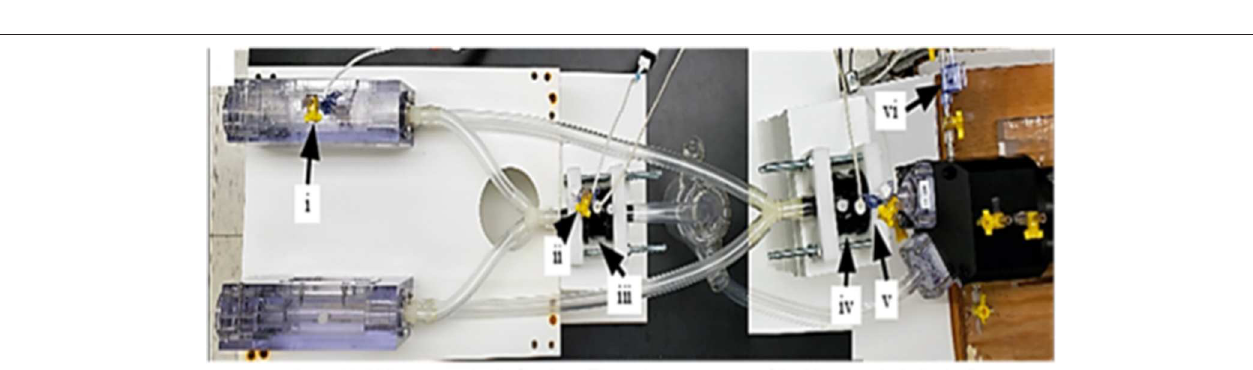
FIGURE 2 | Bioreactor components. (A) View of scaffold holder detailing the positioning of scaffolds with metal pins, (B) bioreactor chamber with imaging window for direct view of scaffold holder within the chamber, and (C) Bioreactor imaging window with scaffolds immersed in flow media. Arrow signifies the direction of flow.